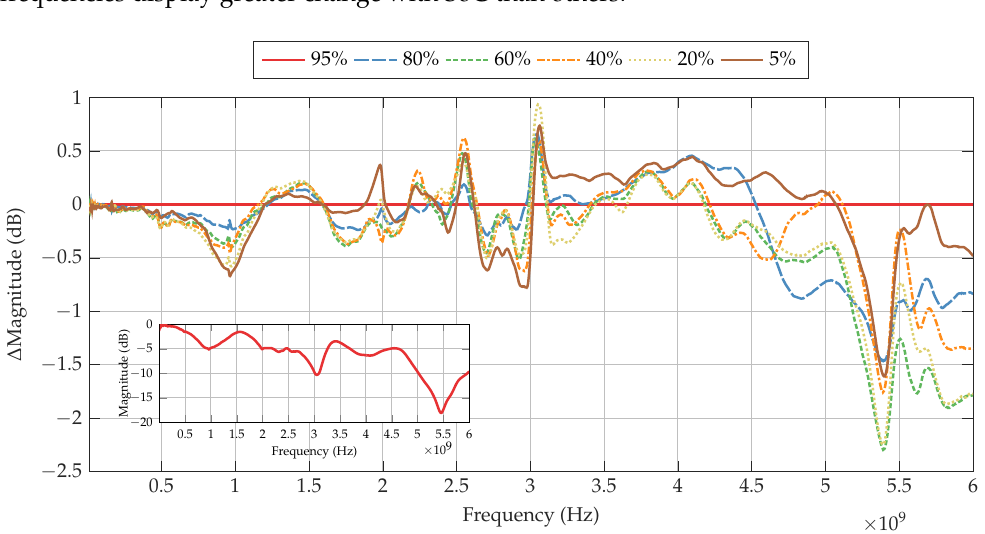
Figure 8. Change in S21 magnitude of the Li-ion cell at various SoCs, using 95% SoC as a baseline. Inset shows the baseline S21 magnitude of the Li-ion cell at 95% SoC.